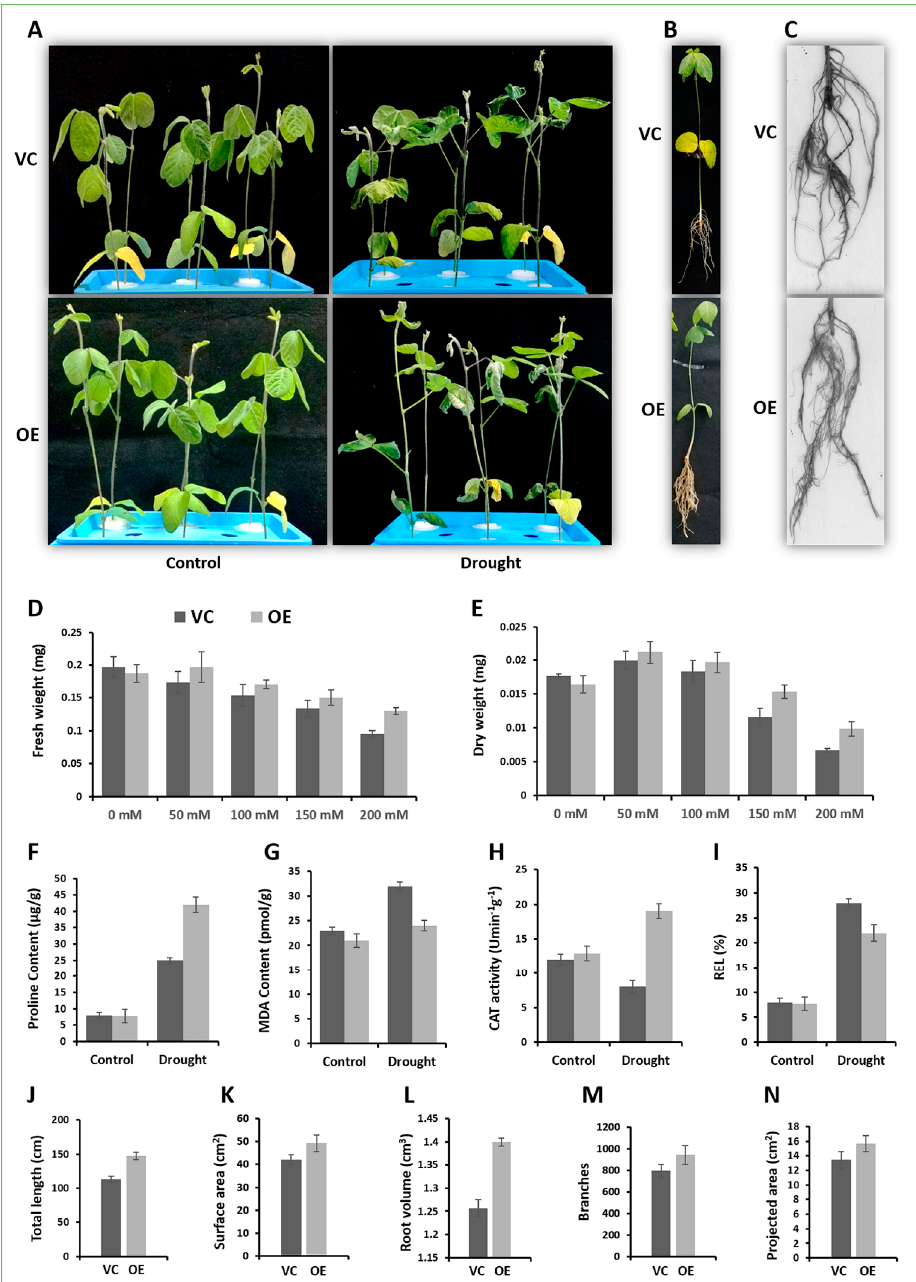
Figure 6. Comparative phenotype and physiology of chimeric sobean plants. ( A ) Chimeric soybean plants bearing VC (Vector control) roots and OE (overexpressing GmCAMTA12) roots in control and drought conditions. ( B ) Comparison of chimeric soybean plants having VC and OE roots. ( C ) VC and OE hairy roots observed with a root scanner. ( D ) Fresh and ( E ) dry weight of VC and OE hairy roots after culturing on MS-mannitol for 10 days. Comparison of VC and OE hairy roots in terms of ( F ) Proline contents, ( G ) MDA contents, ( H ) CAT activity and ( I ) relative electrolyte leakage between VC and OE hairy roots. ( J ) Analysis of the total length, ( K ) surface area, ( L ) root volume, ( M ) number of branches and ( N ) projected area.